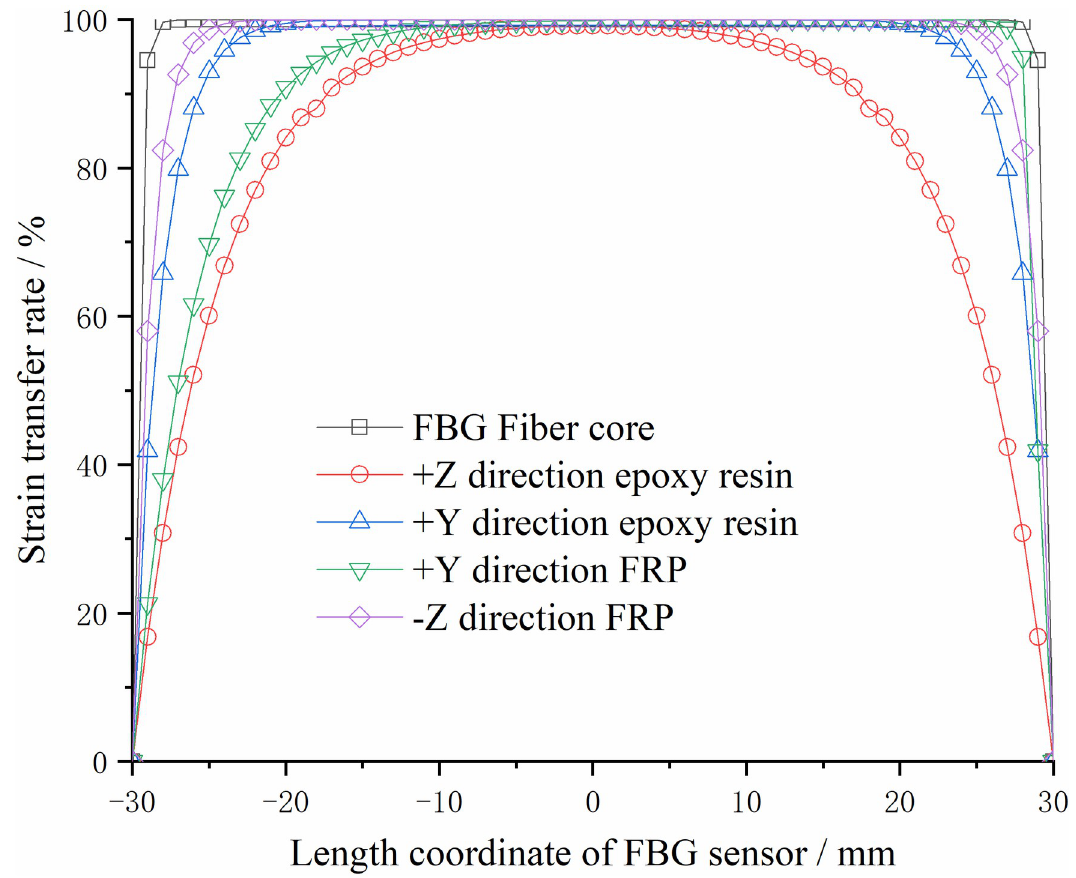
Fig 5. Relationship curve between strain transfer rate of FRP substrate and length